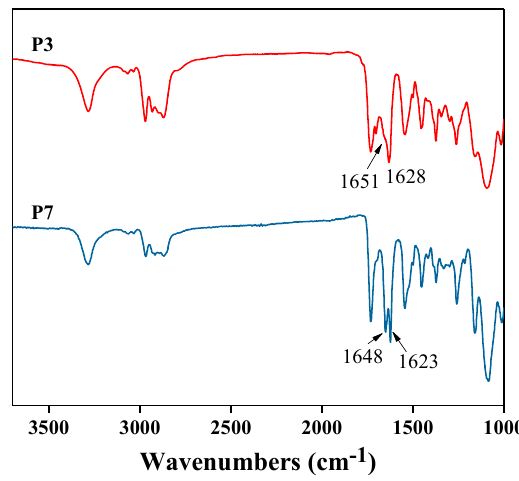
Figure 2. Fourier transform infrared (FTIR) spectra of P3 and P7 .